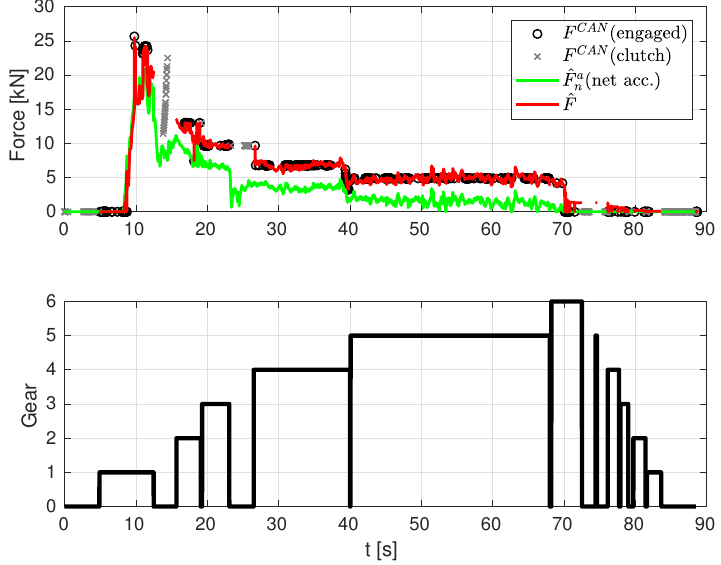
Figure 10. Engine force from CAN messages (with gear engaged and during shift) and estimated force (net acceleration) and estimated force with losses